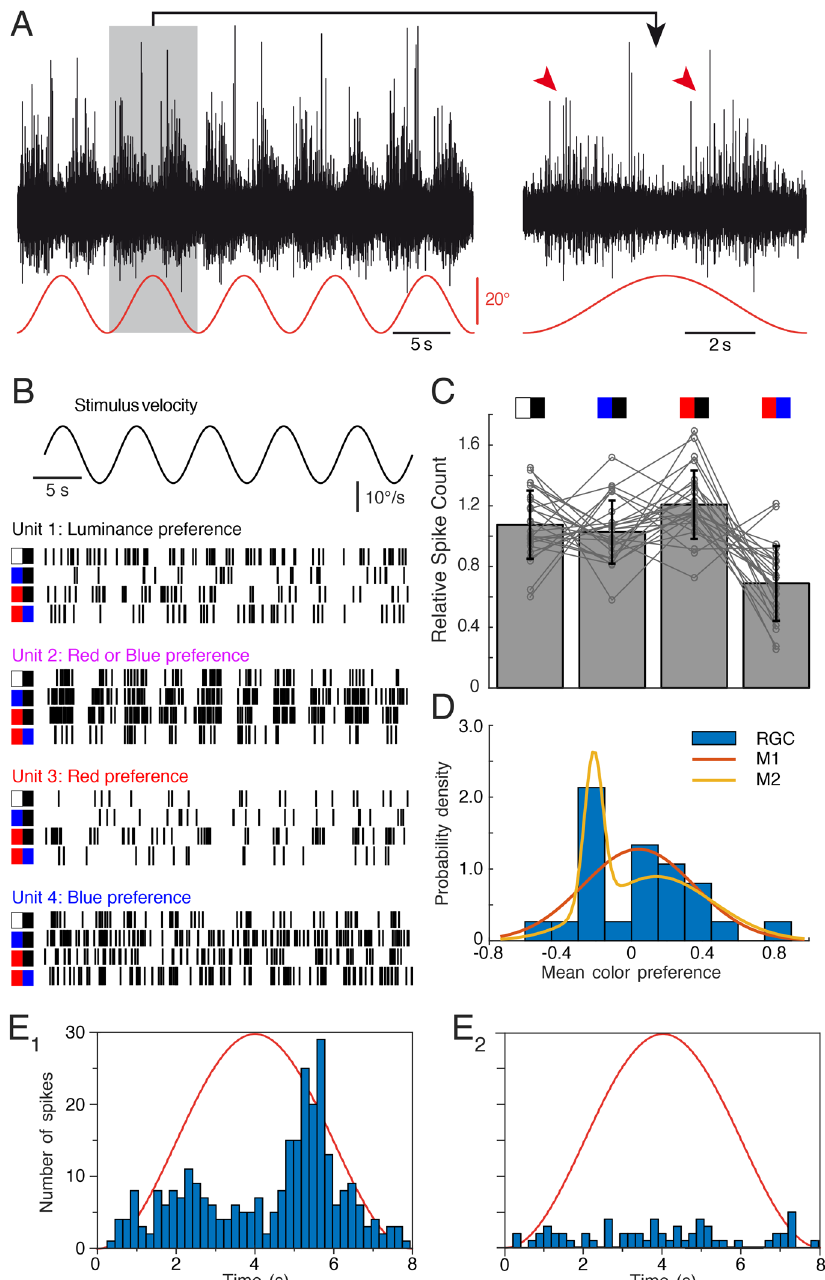
Figure 4. Retinal ganglion cell spike discharge during visual image motion stimulation with different color combinations in isolated optic nerves—eyes of Xenopus tadpoles. (A) Representative multi-unit spike discharge of the optic nerve in response to large-field visual motion stimulation with a black–white striped vertical pattern (red trace); the trace on the right is a magnified view of a single motion cycle (grey area) of the trace on the left; note the bidirectional velocity sensitivity (red arrow heads). (B) Raster plot of spike trains of four isolated individual units with different radiance or color preferences; units respond preferentially to high radiance contrast (unit 1), to blue or red versus black (unit 2) or to red or blue stimulus combinations (units 3 and 4). (C) Bar plot depicting relative spike counts of all isolated units ( n = 25) during visual motion stimulation with different color combinations (icons on top). (D) Histogram of color preferences of n = 25 individual retinal ganglion cell units (RGC, blue). Negative color preference indicates preferential responses to achromatic stimuli, positive values indicate larger responses to single-colored visual motion. Red and yellow curves depict distributions from Gaussian mixture models with one (red, M1) or two (yellow, M2) components fitted to the data. (E) Peri-stimulus time histogram of the average spike discharge (200 ms bin width) over a single image motion cycle at 0.125 Hz (8 s) of two single units (E 1 ,E 2 ) at the POE; note the residual directional response of the unit in (E 1 ) ; red sinusoids represent stimulus cycles. Figure assembled with Affinity Designer (version